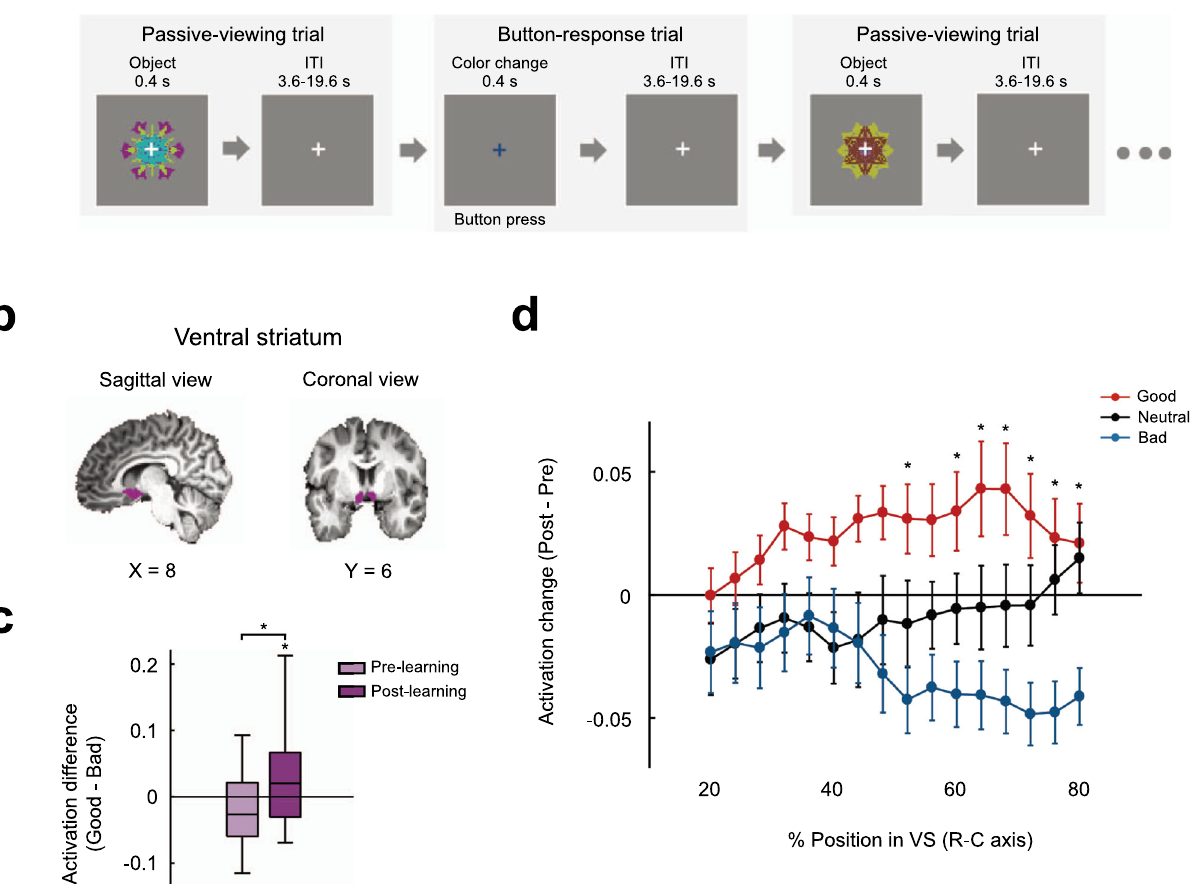
Fig. 3 Average magnitude of the BOLD response in the human ventral striatum before and after learning. a The passive-viewing task of the Pre-learning or Post-learning fMRI sessions consisted of passive-viewing trial and button-response trial types. On each passive-viewing trial, a fractal object was presented with the white fi xation cross, while during each button-response trial, a blue or red fi xation cross was presented in the absence of an object. Before the task, participants were instructed to keep their eyes on the fi xation cross and to press a button if the white fi xation cross changed to blue or red. b The ventral striatum (VS, purple) delineated on the MNI brain. c Boxplots for the difference in the response magnitude between the good and the bad objects during the Pre-learning and Post-learning sessions. The responses for good objects were signi fi cantly greater than those for bad objects after fi ve days of learning ( n = 22 participants, one-tailed one-sample t test against 0, * p = 0.027), but not before learning. Moreover, the activation difference after learning was signi fi cantly greater than that before learning (one-tailed paired t test, * p = 0.011). The middle line indicates the median, and the bottom and the top of the box correspond to the 25th and 75th percentiles, respectively. The upper and lower whiskers extend to the highest and lowest values that are within 1.5 times interquartile range of the hinge. Outlying data beyond this are plotted as dots. d The difference in the response magnitude between the Pre- learning and Post-learning scan sessions for good, neutral, and bad objects at different locations of the VS along the rostral-caudal axis. In the middle and caudal regions, the responses to the good objects were signi fi cantly greater than the responses to the bad objects ( n = 22 participants, one-way ANOVA with value as a factor for each position between the position of 52% of voxels and the caudal end, * p < 0.048; post hoc Bonferroni pairwise comparison, all * p < 0.046 except for the position of 56% of voxels from the rostral end). Error bars indicate between-subjects passive-viewing trials before ( t = 8.983, p = 1.223 × 10 − 8 ) and after with a white fi xation cross, while the color of the fi xation cross ( t = 5.528, p = 1.744 × 10 − 5 ) learning in the salience network, which is thought to be a higher-order system for the identi fi cation if the color of the fi xation cross changed to red or blue. A monetary saliency 22,23 (Supplementary Fig. 3a). These fi ndings indicate that